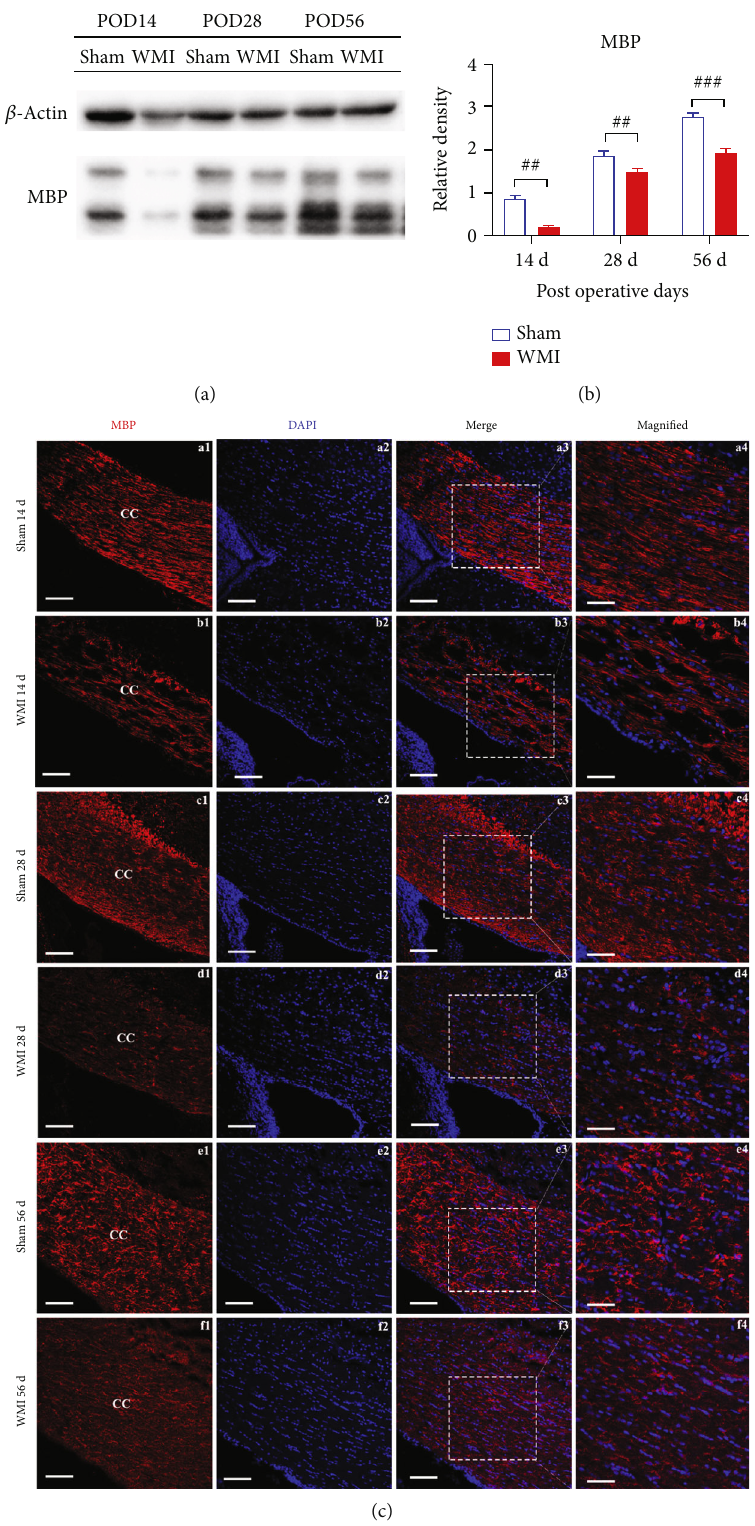
Figure 1: E ff ect of hypoxia-ischemia on the expression of MBP in rat brains. (a) Representative Western blot images of MBP bands and PODs (postoperative days). (b) Quantitative analysis of MBP protein expression ( ## p < 0 : 01 and ### p < 0 : 001 vs. sham group, n = 4 ). The results showed that the MBP level was clearly reduced in the WMI group compared with the sham group. (c) Double immuno fl uorescence staining of MBP (red) and DAPI (blue). Among them, a3, c3, and e3 are the high-magni fi cation images in the white line square areas of b3, d3, and f3. CC: corpus callosum; a1 – a3, b1 – b3, c1 – c3, d1 – d3, e1 – e3, f1 – f3, bar = 50 μ m ; a4, b4, c4, d4, e4, f4, bar = 25 μ m